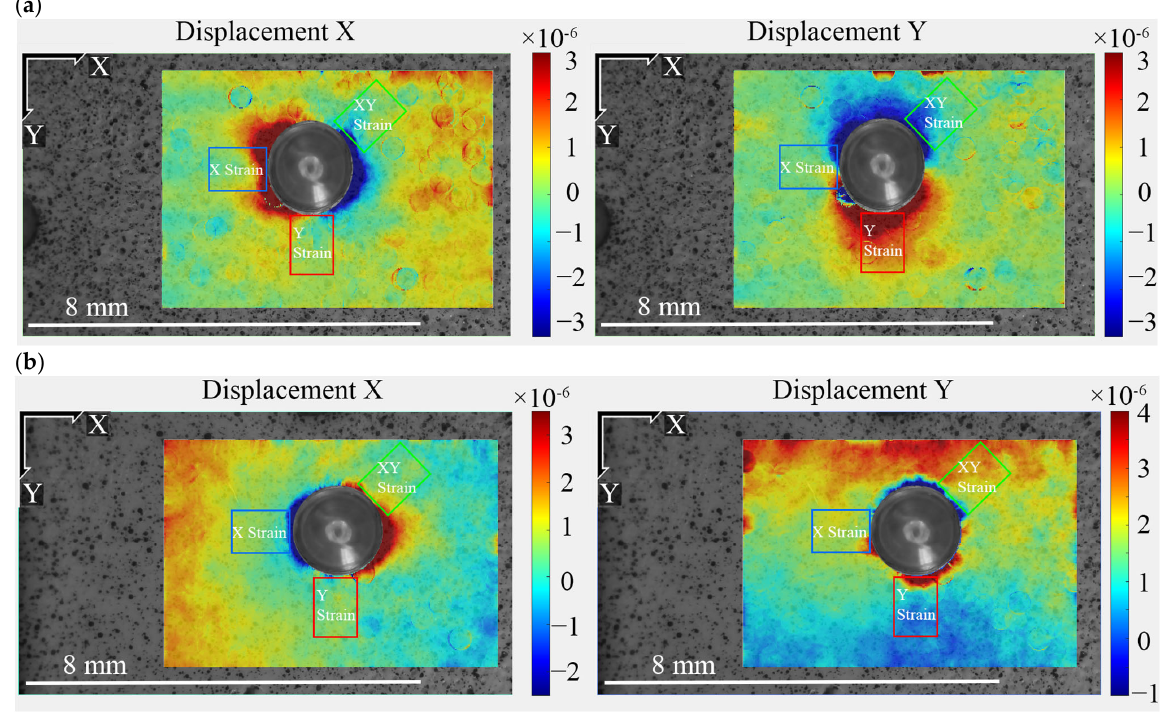
Figure 7. Displacement X and Y at point C ( a ) and point T ( b ) caused by strain relief due to the hole drilling, measured using Ncorr, showing locations of virtual strain gauges.